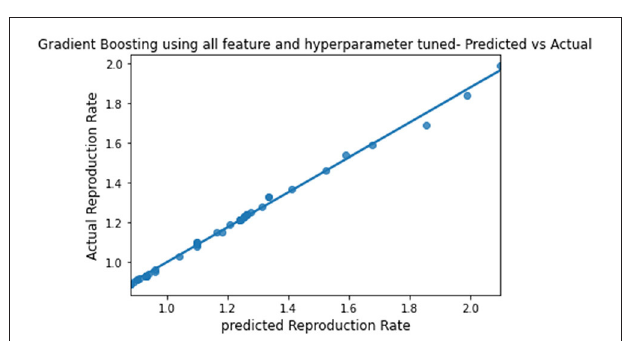
FIGURE 7 | Graph describing the predicted value vs. actual value of Random Forest.